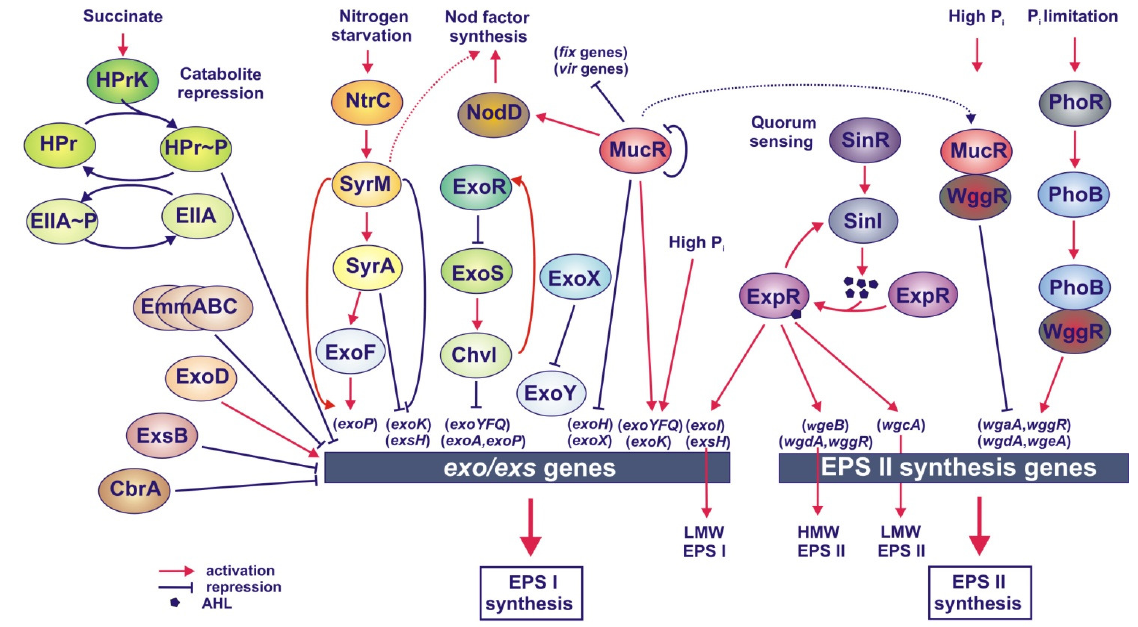
Figure 3. Model of the regulatory network correlating exopolysaccharide production, quorum sensing and catabolite repression in S. meliloti